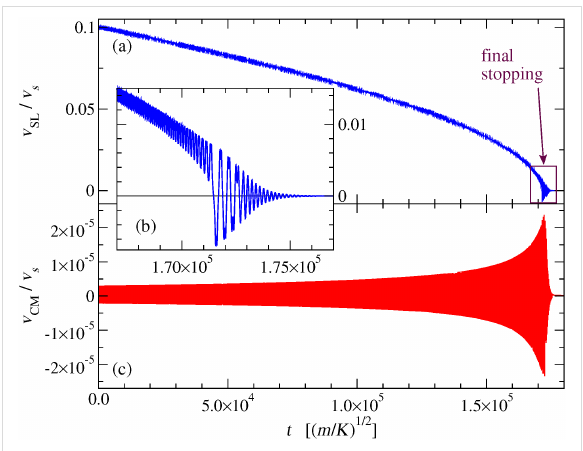
Figure 3: The time dependence (a) and (b) of the slider velocity v SL and (c) of the chain center of mass v CM for the second simulation (freely-slowing mode) of protocol A. The simulation is carried out until the slider finally stops and dissipates its residual energy in oscillations expanded in the inset (b), around a minimum of the effective potential of Figure 2, with chain phonon waves carrying this residual energy away, until the eventual complete arrest of the system. Note the in- creasing negative mean slope of the v SL curve, indicating an increas- ing mean friction force F d as v SL